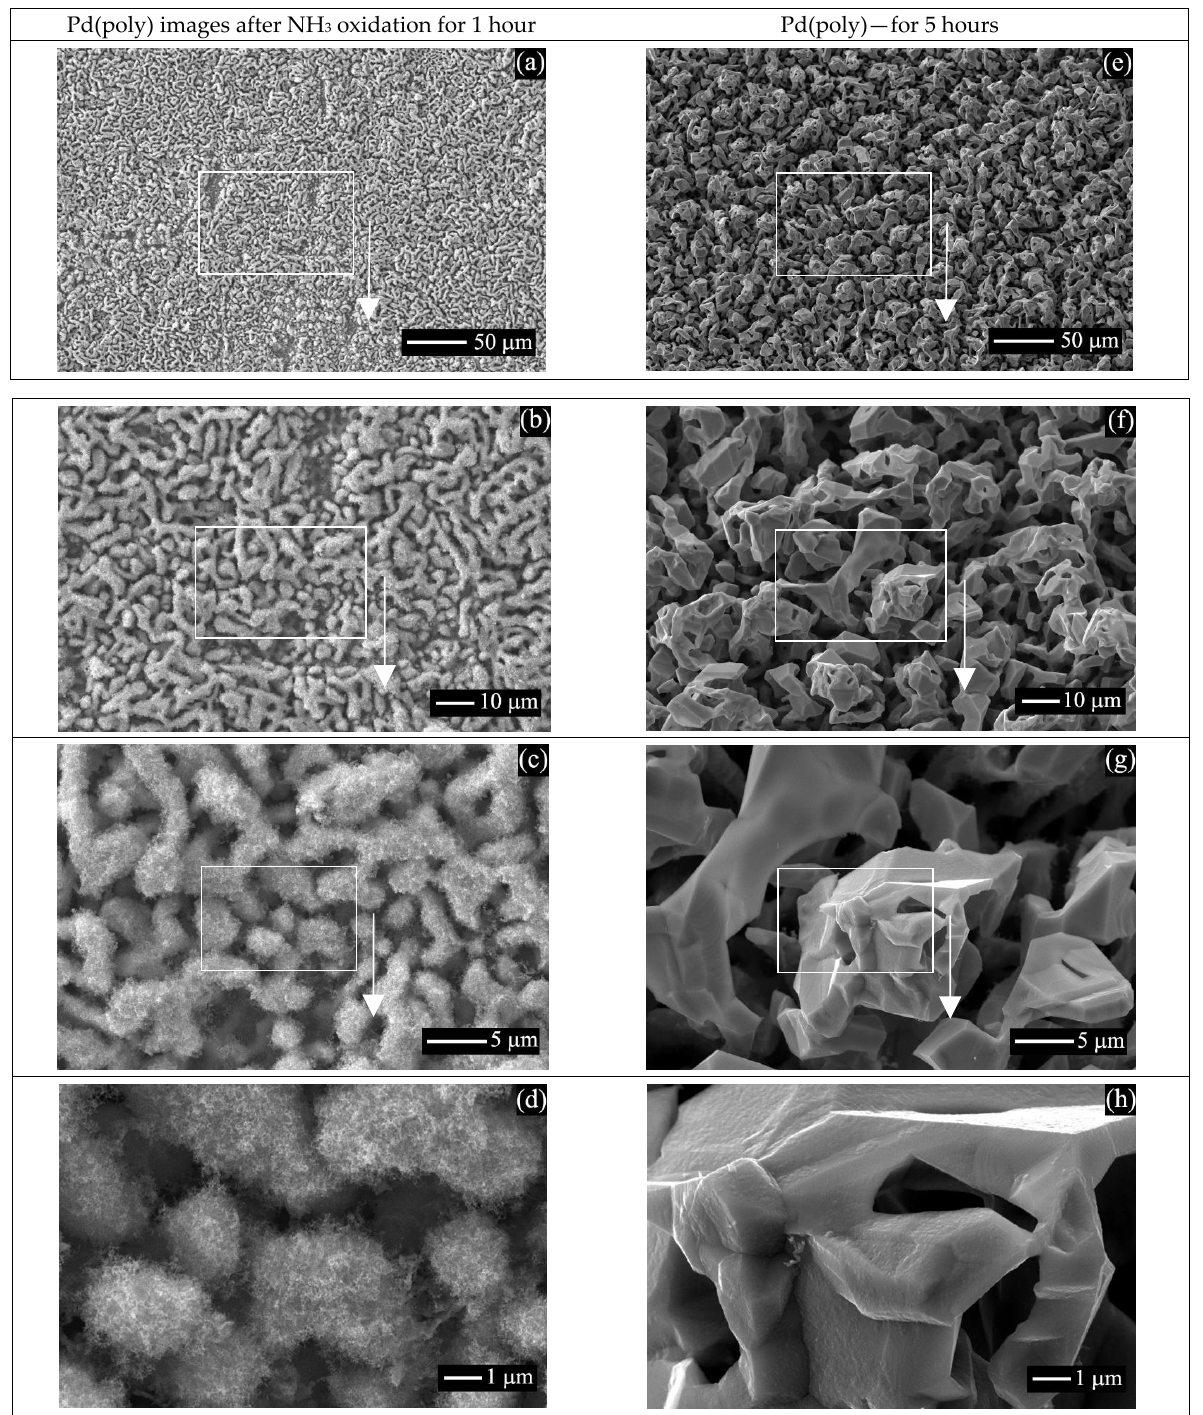
Figure 7. SEM images of the Pd(poly) surface after NH 3 oxidation with air oxygen at T = 1133 K for 1 ( a – d ) and 5 ( e – h ) hours. Images were obtained in SE mode at E 0 = 25 keV; rectangles indicate the regions represented by images with a higher magnification.